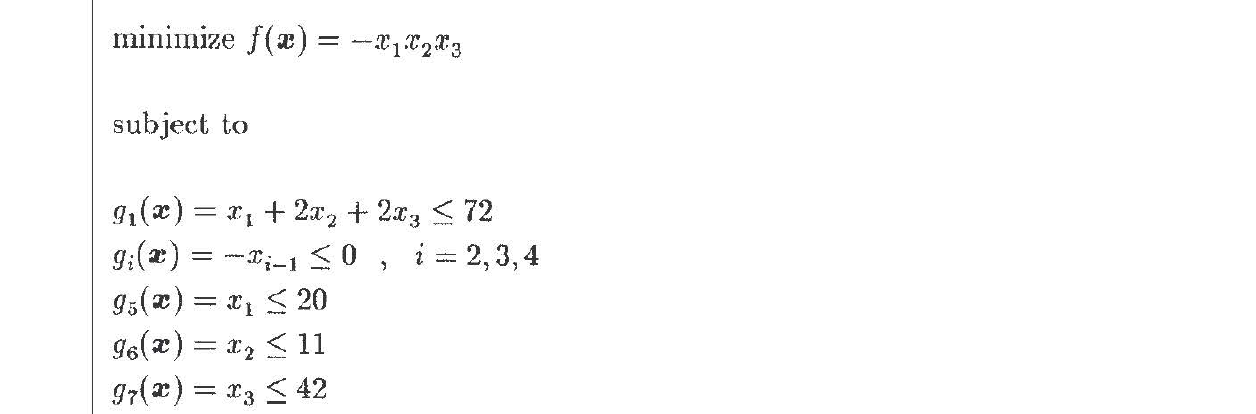
Exa1nple 4 A general non-linear problem with solution at a vertex